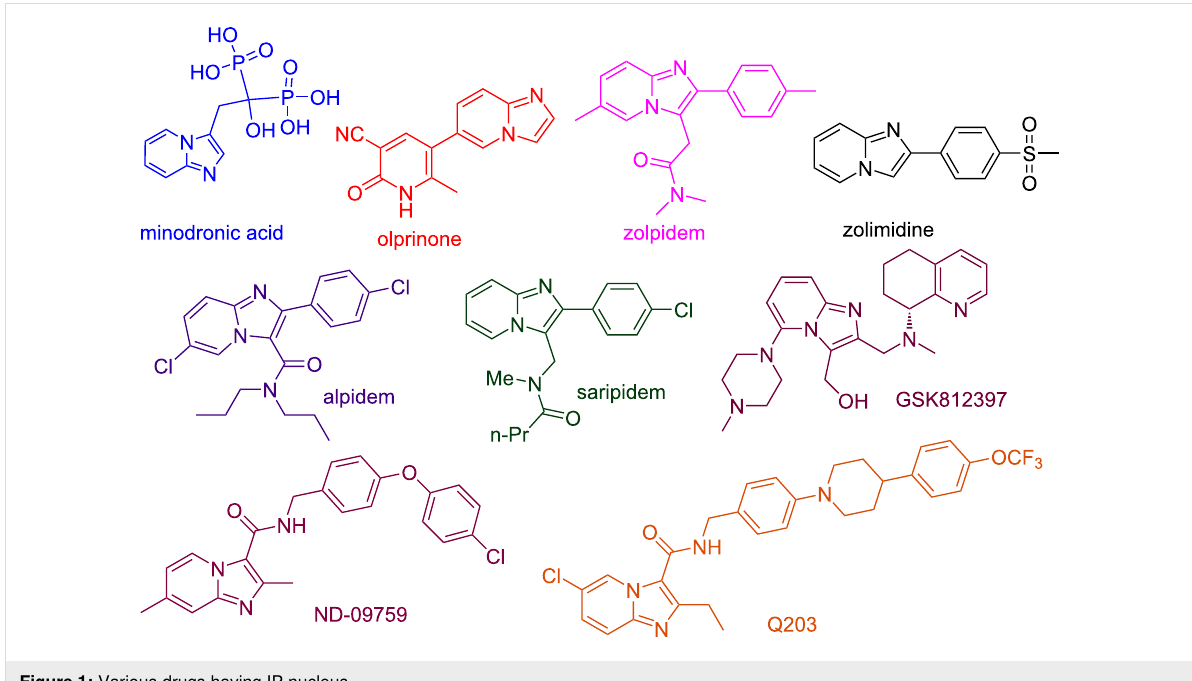
Figure 1: Various drugs having IP